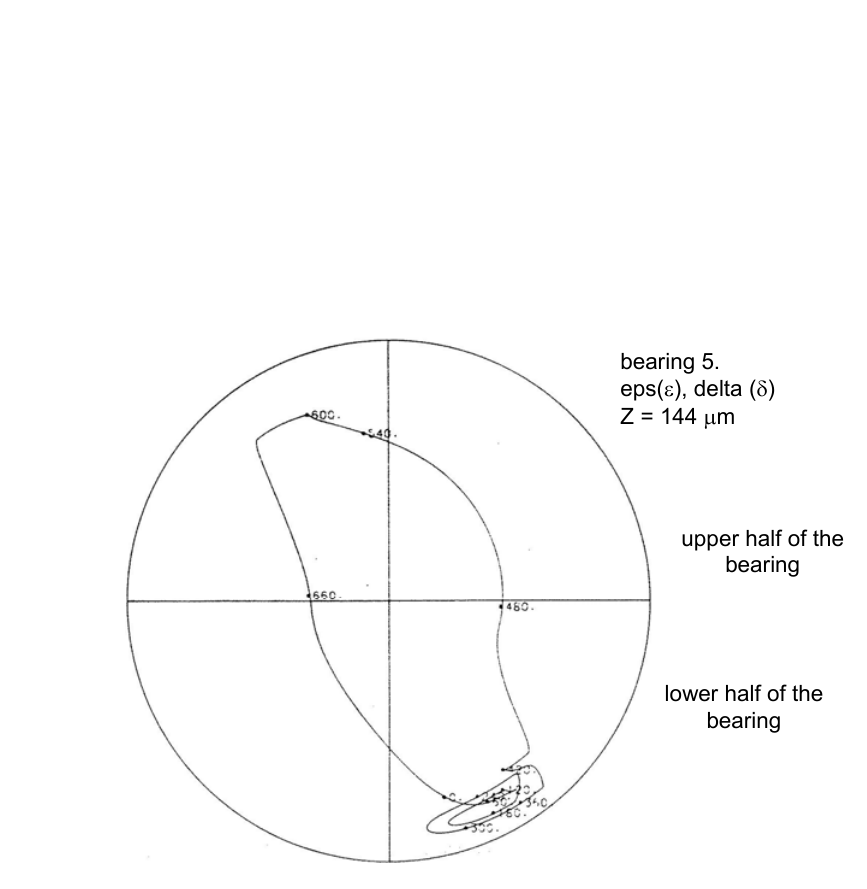
Figure 6 – Dynamic trajectory of the main sleeve of the 5th bearing, the radius of the radial clearance Z = 144 